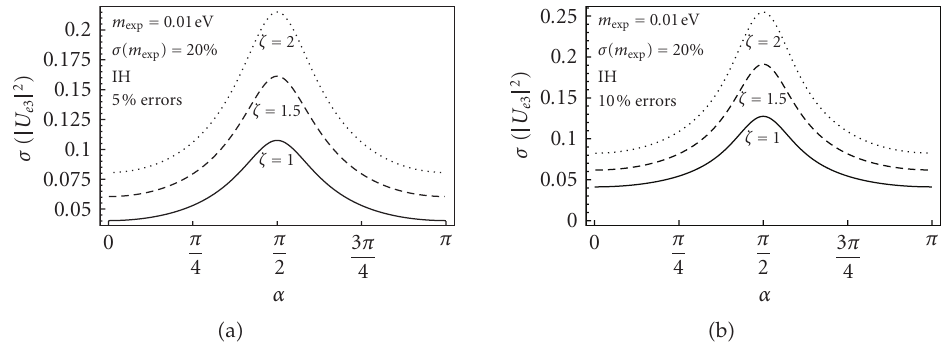
Figure 7: The influence of the nuclear matrix element uncertainty ζ on the error of | U e 3 | 2 in case of an in- verted hierarchy. The errors on Δ m 2 A and sin 2 θ 12 are again 5 and 10%, respectively. σ (cid:6) | U e 3 | 2 (cid:7) grows linearly with ζ